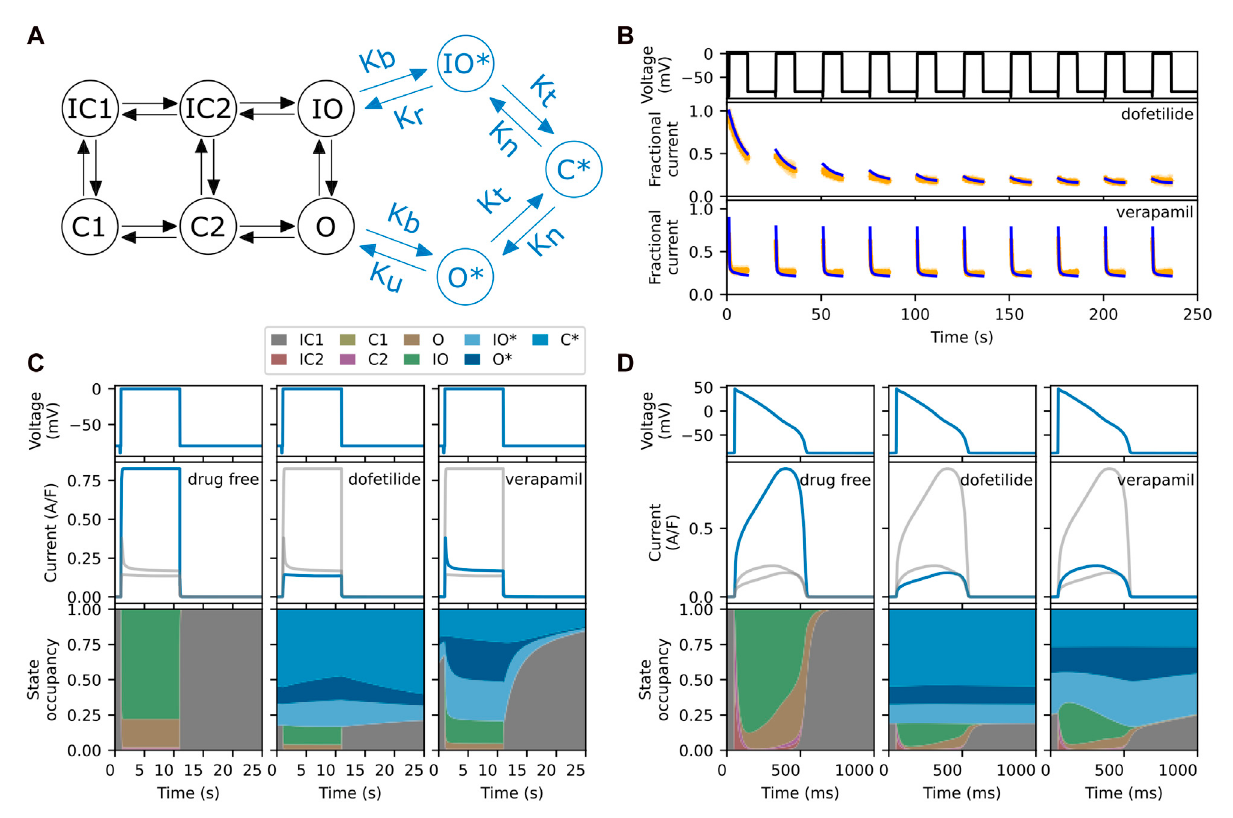
FIGURE 1 (A) The six-state model by Li et al. (2016) (in black) and its extension to model drug block and trapping by Li et al. (2017) (black and blue states). (B) Fractional block predictions for 10 paces of Milnes ’ protocol (top) for the SD model with a trapped drug, dofetilide (middle) and a non-trapped drug, verapamil (lower). The SD model ’ s response (blue) is overlaid on the experimental data (orange) from Li et al. (2017). (C) Steady state response (after 1,000 paces) for theSD model during asingle step ofMilnes ’ protocol, for adrug-free (left), trapped (middle), and non-trapped con fi guration (right). Thelowerrowshowsthestateoccupancy:thefractionofchannelsinanyonestateatagiventime. (D) LikepanelC,butusingapredeterminedelongated APsignal(1 s)insteadofarectangularpulse(25